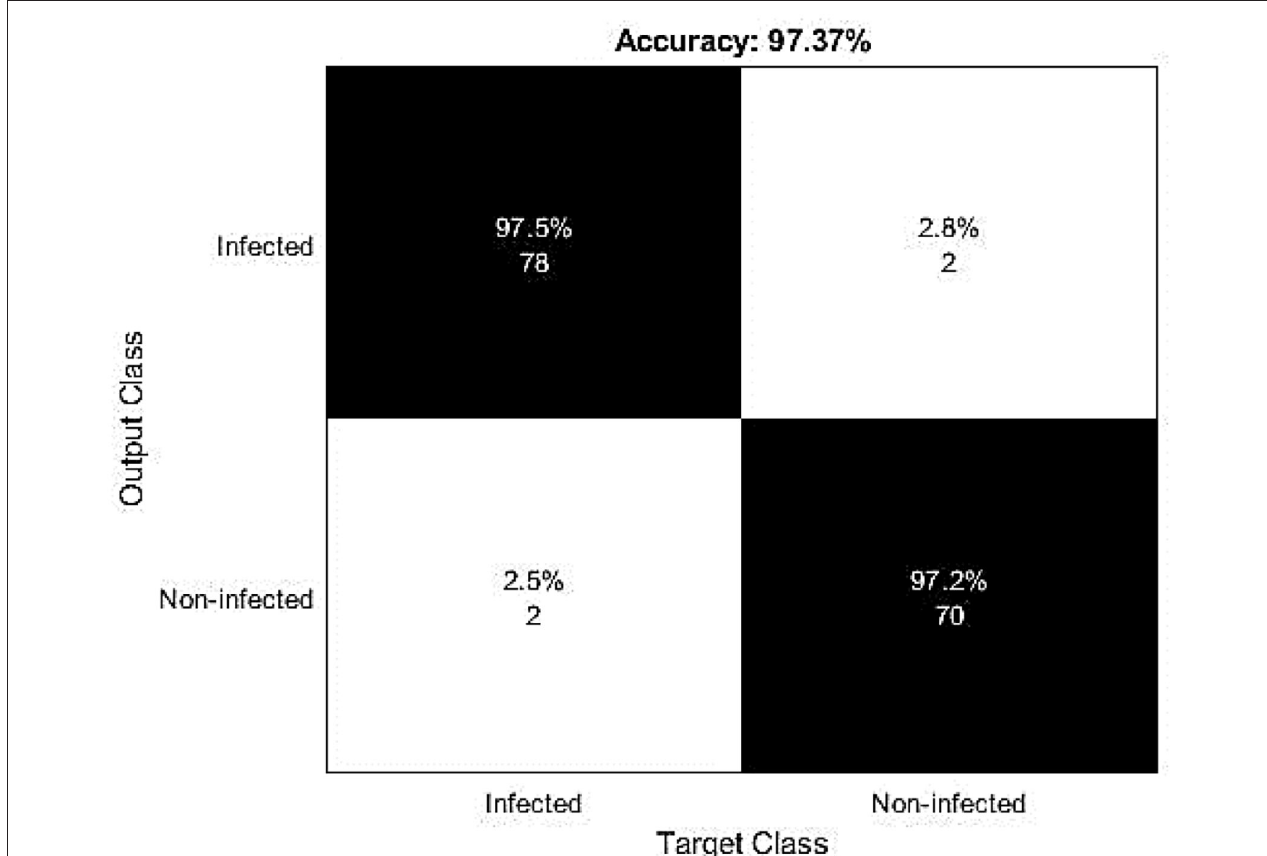
FIGURE 6 | The confusion matrix reflects the recognition capabilities of the proposed research study.